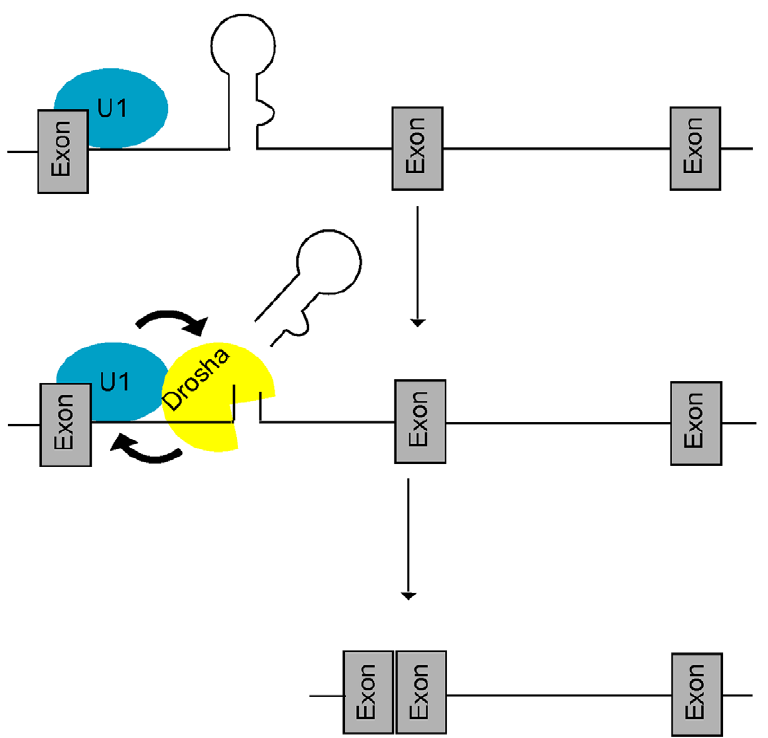
Figure 5. A feed-forward model of microprocessing and splicing. At intronic miRNA loci, the U1 complex first recognizes the 5 9 SS and promotes (arrow) recruitment of Drosha, leading to increased microprocessing and rapid clearance of the miRNA hairpin. Increased cropping by Drosha in turn generates a better splicing substrate by stabilizing both the cut intron and 5 9 SS binding by the U1 complex (arrow) thus promoting splicing completion. Mutually-cooperative splicing and microprocessing activities result in increased exon-exon junction formation at intronic miRNA